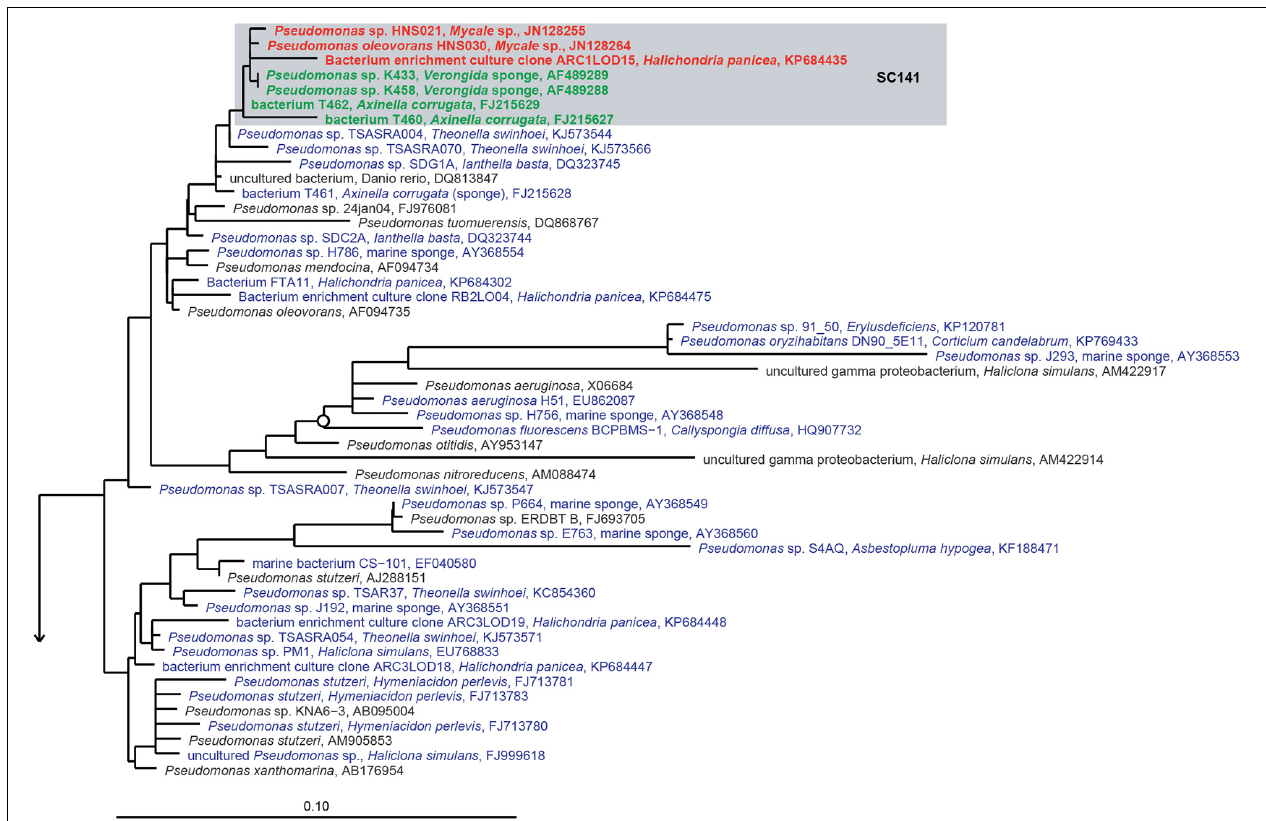
FIGURE 5 | 16S rRNA gene-based phylogeny of sponge-specific cluster SC141 within the Gammaproteobacteria . Filled circles indicate bootstrap support of ≥ 90%, and open circles represent bootstrap support of ≥ 75%. SC indicates sponge-specific cluster, and SCC indicates sponge- and coral-specific cluster. Blue letters indicate cultured bacteria from sponges, bold green letters indicate cultured bacteria belonging to known SC(S)s by Simister R.L. et al. (2012), and bold red letters indicate newly cultured bacteria added into known